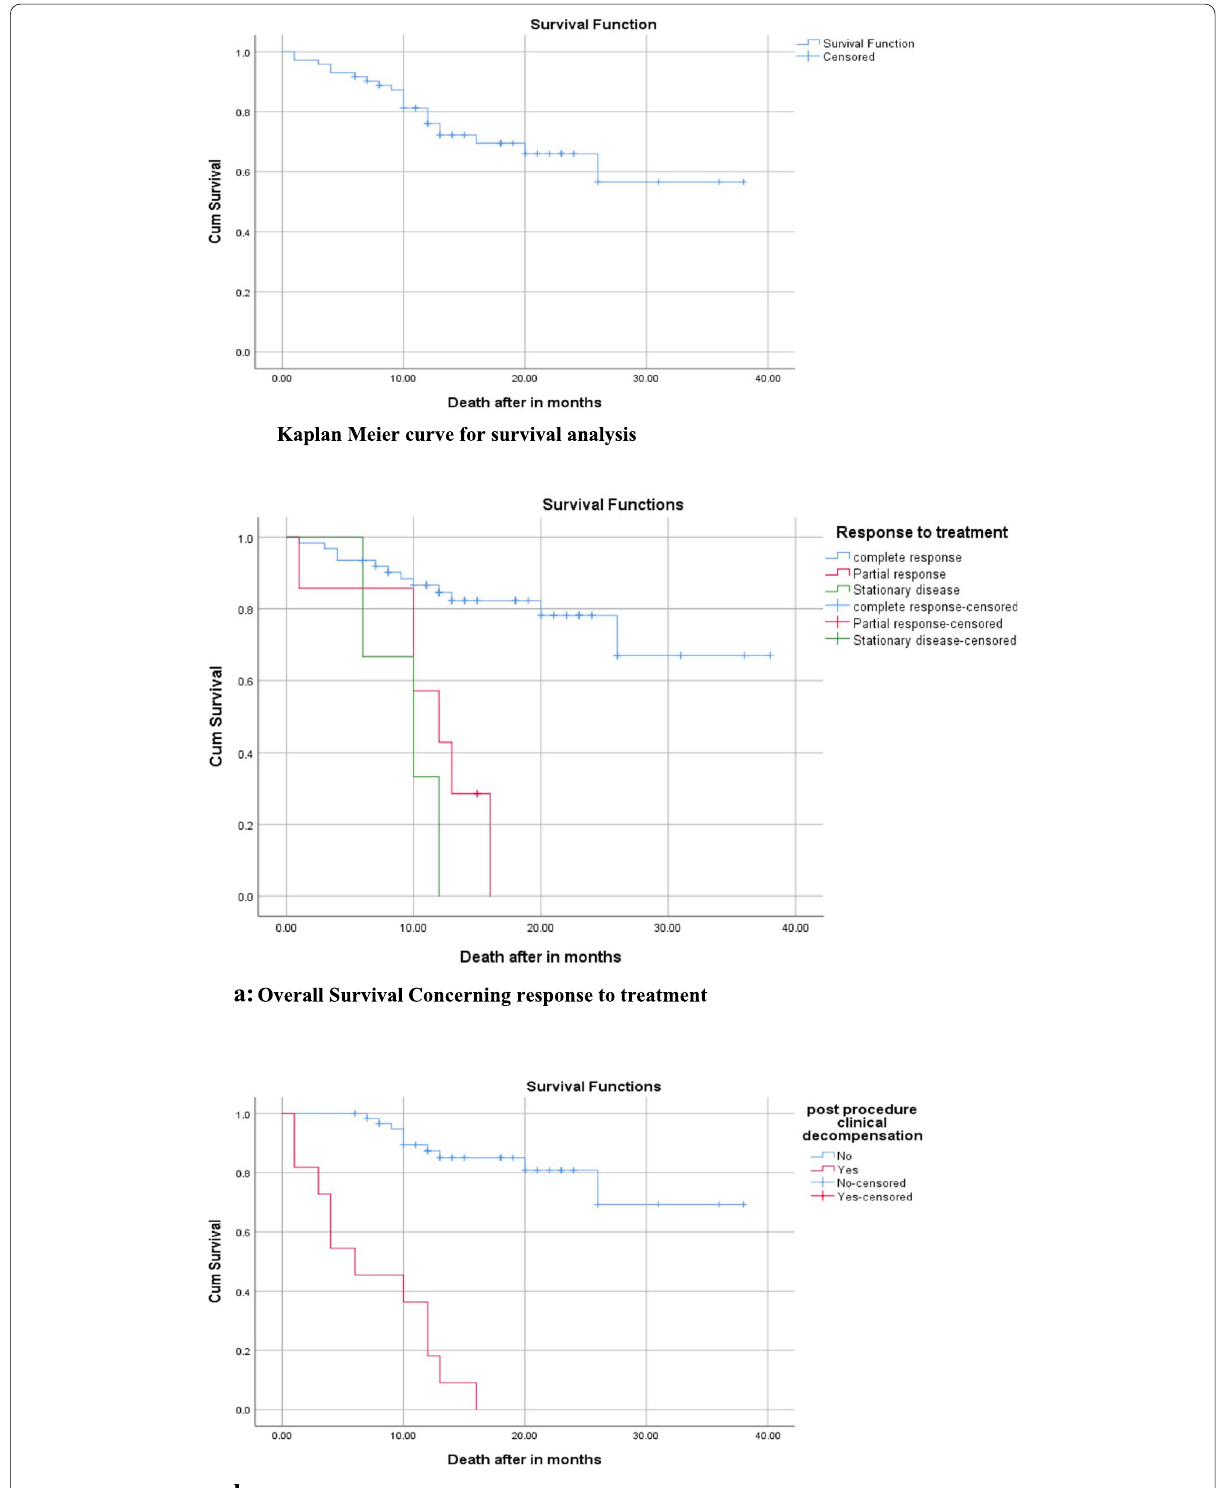
Fig. 1 Kaplan–Meier curve for survival analysis. a Overall survival concerning response to treatment. b Overall survival concerning post-treatment clinical